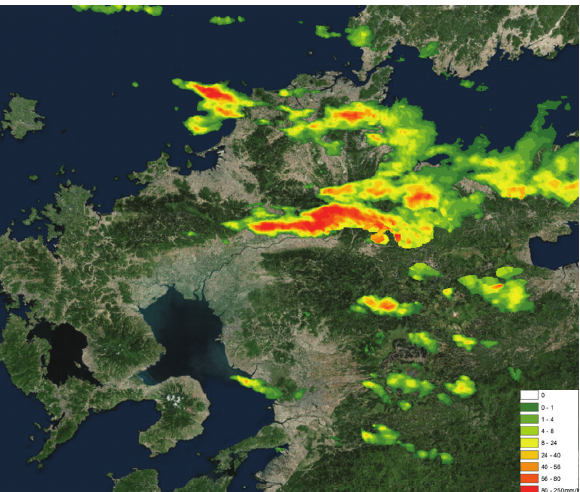
Figure 8. Result of inputting rainfall information of the X-band MP radar into GIS (2017.7.5